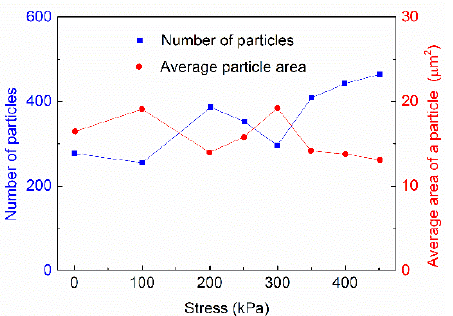
Figure 5. Stress-dependent particle characteristics of soft marine soil (e.g., number of particles and average area of particles).